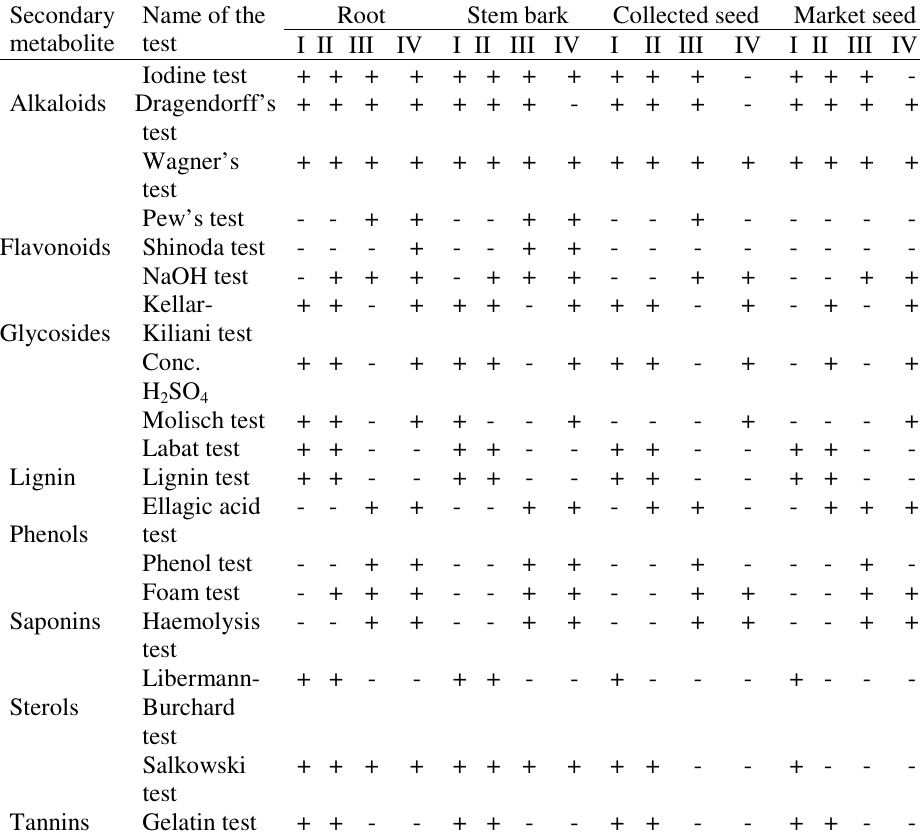
Table 1 .Preliminary screening of secondary metabolites from